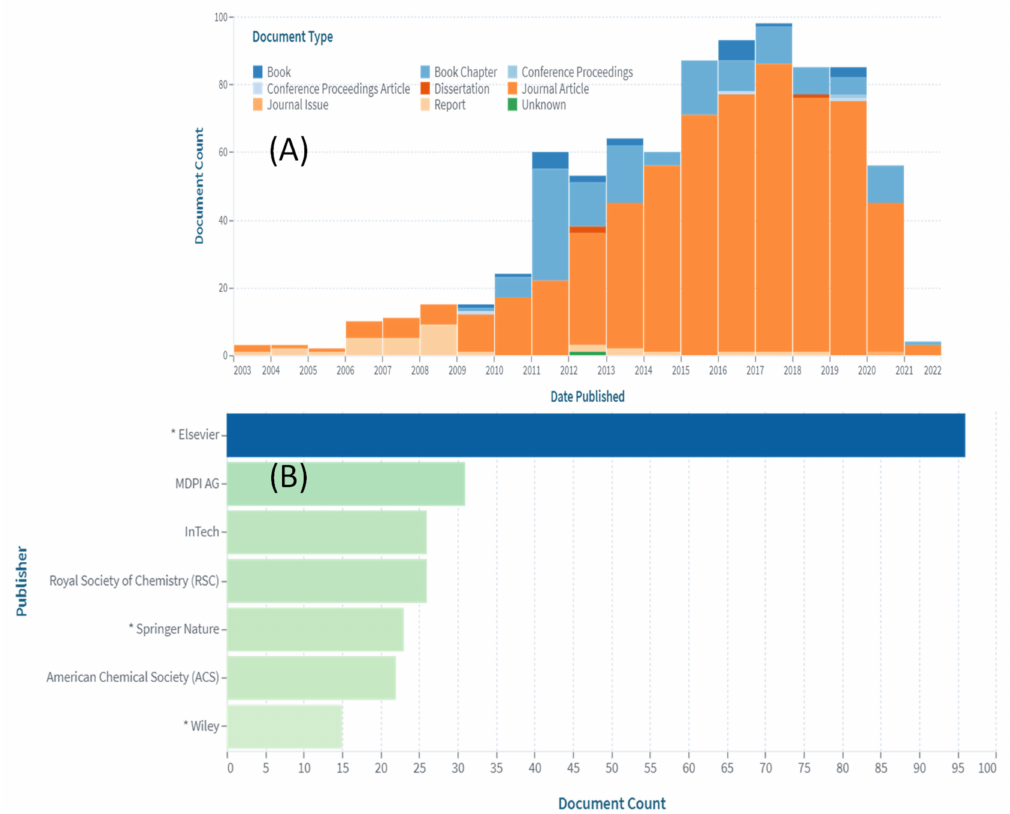
Figure 7. ( A ) The annual number of scholarly works on SACs and biofuel and ( B ) scholarly work on SAC and biofuel (published by top 5 publishers). (The Lens (formerly Patent Lens) scholar analysis search system, search term “single-atom- catalyst AND biofuel” within 2000–2021). https://link.lens.org/LXnxsRHrG9c (accessed 11 October 2021). * The annual number of scholarly works on SACs and